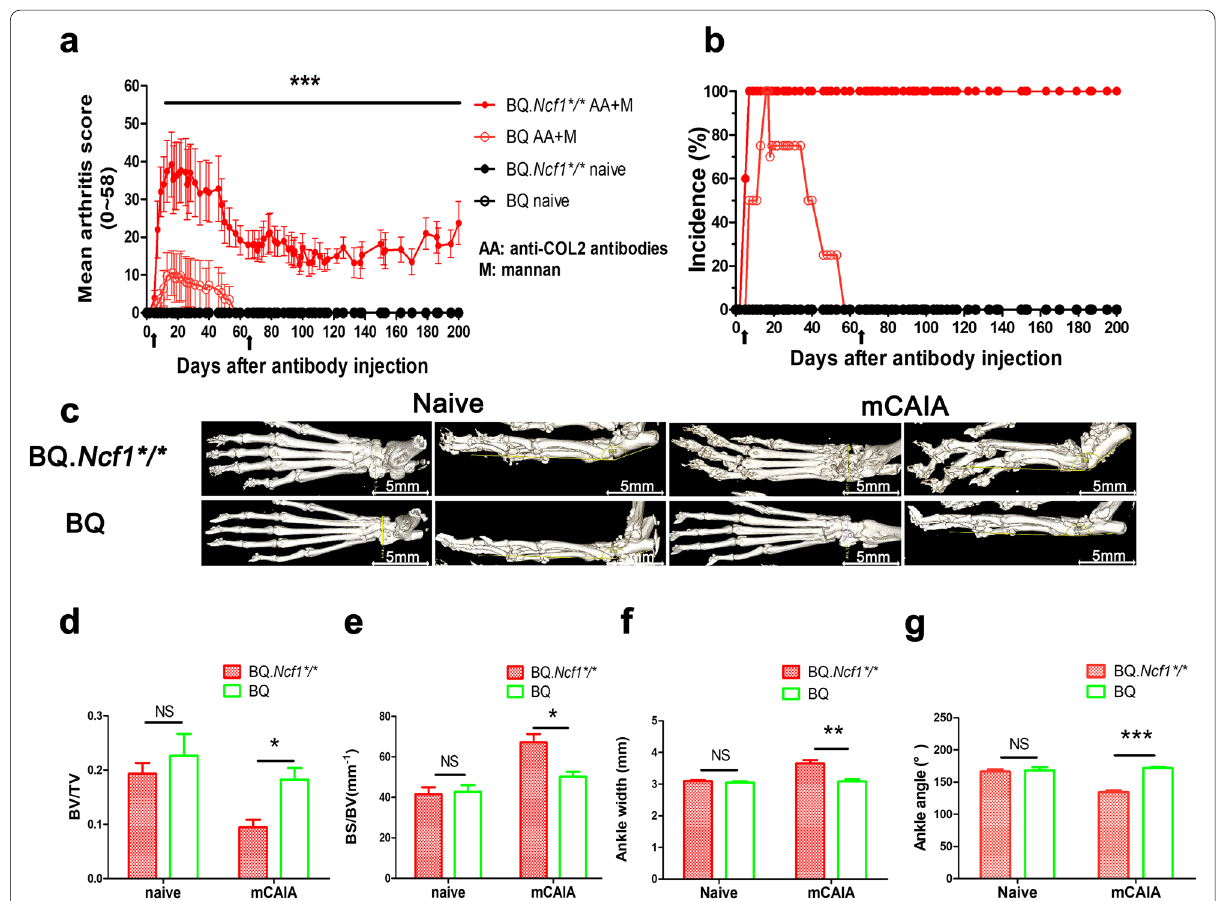
Fig. 2 Bone damage in BQ. Ncf1*/* mouse paws during chronic arthritis. BQ. Ncf1 */* mice and BQ mice in mCAIA group (14–16 weeks old, n naïve group ( n 3) on day 200. a Arthritis score, ( b ) Disease incidence from day 100 to 200. c Representative images of mouse paws on day 200. = Bone volume / Total volume (BV/TV) ( d ), Bone surface area / Bone volume (BS/BV) ( e ), ankle width ( f ) and ankle angle ( g ) in the distal region of the tibia were analyzed. Black arrows indicate i.p. injection of 4 mg of mannan each time per mouse, total 2 times. The data shown are mean two-tailed Mann-Whitney U test was used to calculate the level of significance. BQ. Ncf1 */*